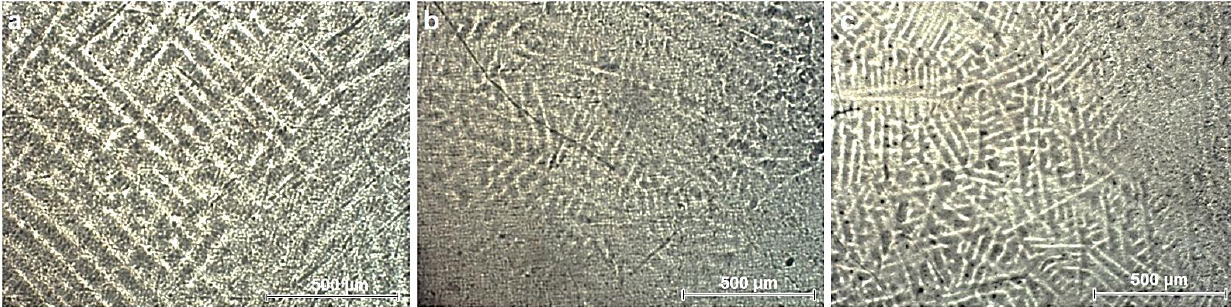
Figure 1. Microscopy images of substrate materials: ( a ) Ti15Mo7Zr5Ta; ( b ) Ti15Mo7Zr10Ta; ( c ) Ti15Mo7Zr15Ta. Morphological aspects of coated samples with hydroxyapatite coating are presented in Figure 2.